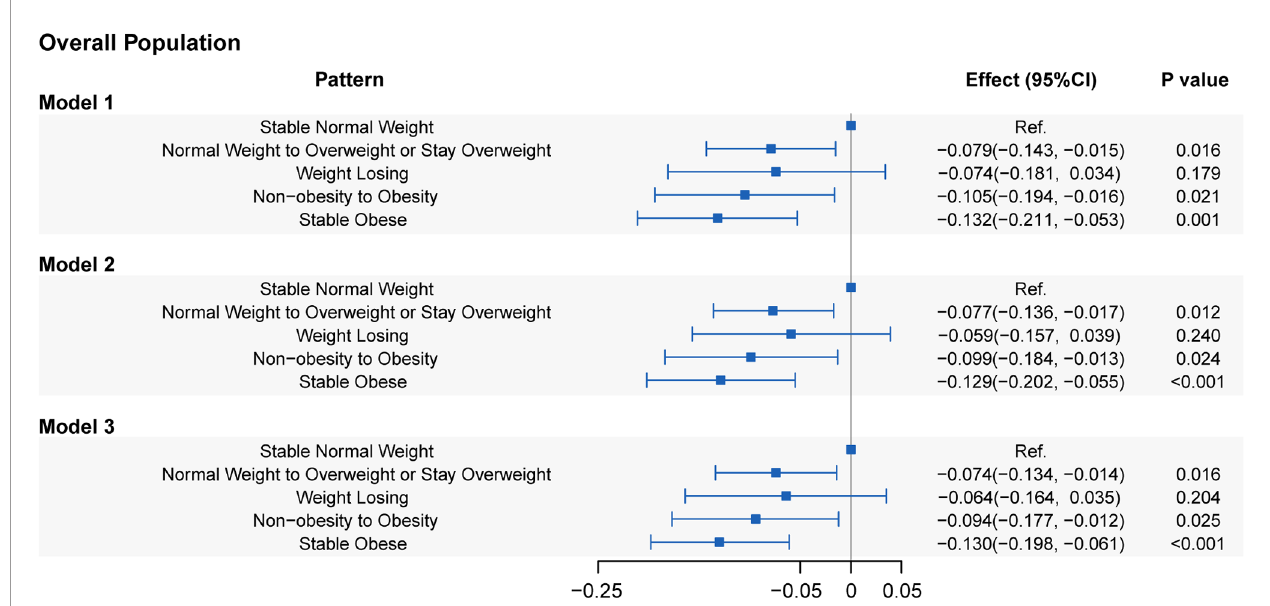
FIGURE 2 | Associations of leucocyte telomere length with fi ve weight change patterns. Model 1 : adjusted for age, sex, and race/ethnicity. Model 2 : adjusted for covariates in Model 1 plus educational level, family PIR, physical activity, energy intake, alcohol use, and smoking status. Model 3 : adjusted for covariates in Model 2 plus self-reported health, family history of diabetes, family history of angina, cardiovascular disease, diabetes, and